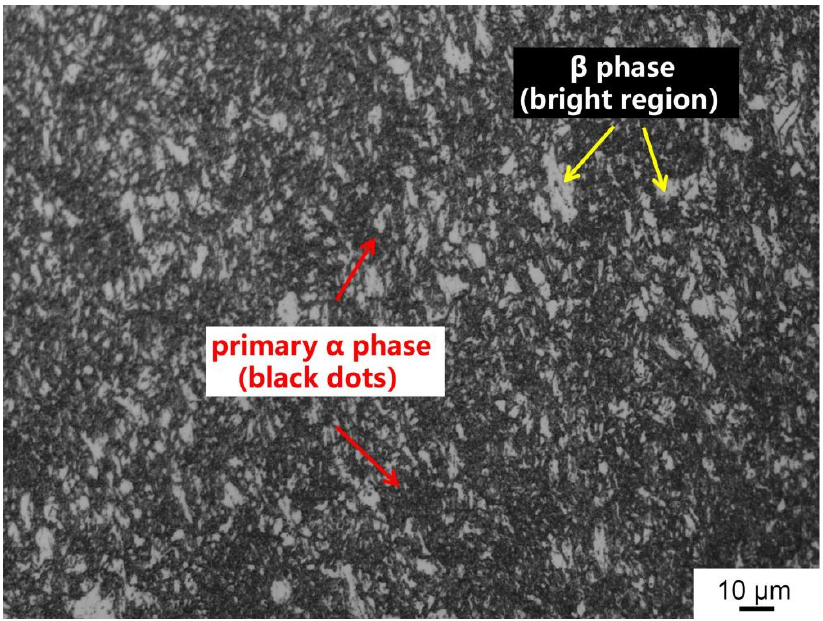
Figure 1. Hot-rolled microstructure (1000×) of Ti-B12 alloy.